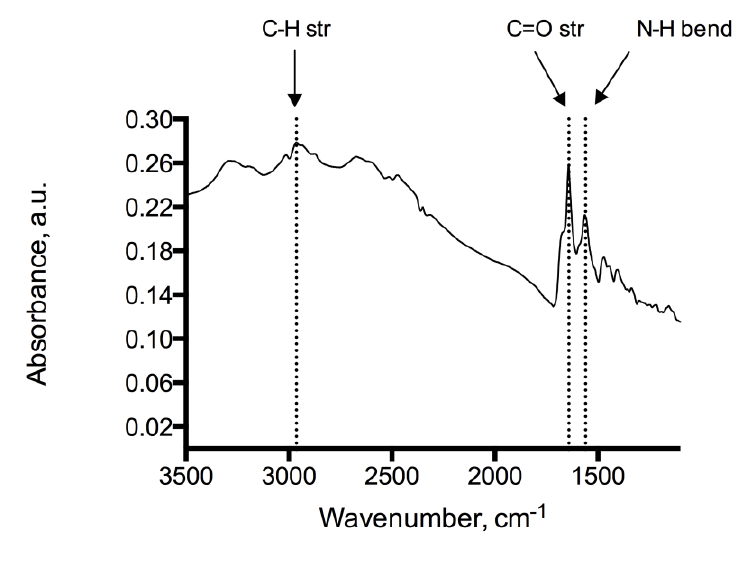
Figure 4. IR-spectrum of the adenine coated Au/quartz surface showing N–H (1560 cm −1 ), C=O (1641 cm −1 ) and C–H (2964 cm −1 )